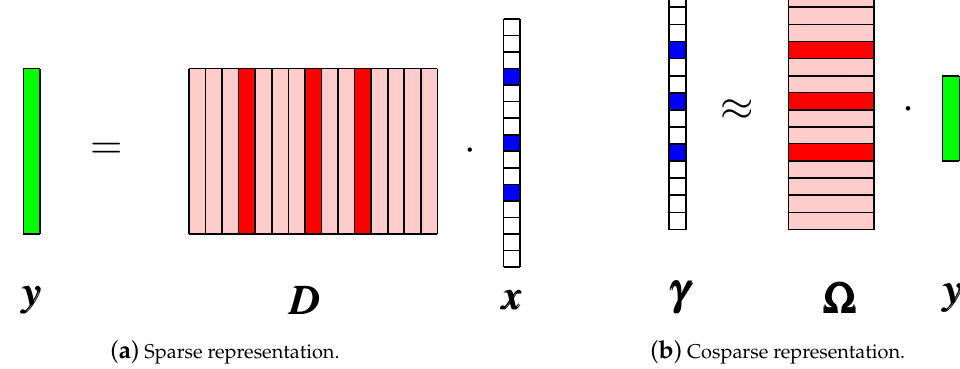
Figure 1. Sparse/cosparse representation of a signal ([15], Chapter 1 and 10). The used atoms are red and the nonzero coefficients are blue. The unused atoms are